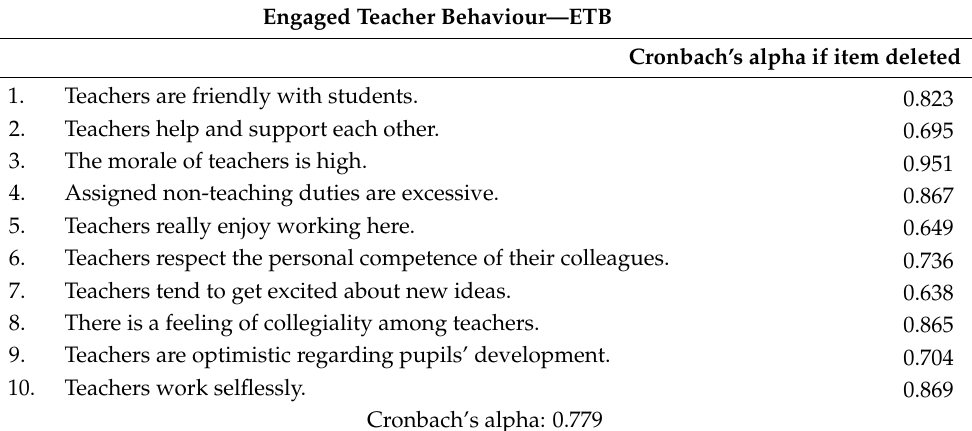
Table 5. Engaged teacher behaviour ETB—Cronbach’s alpha for internal